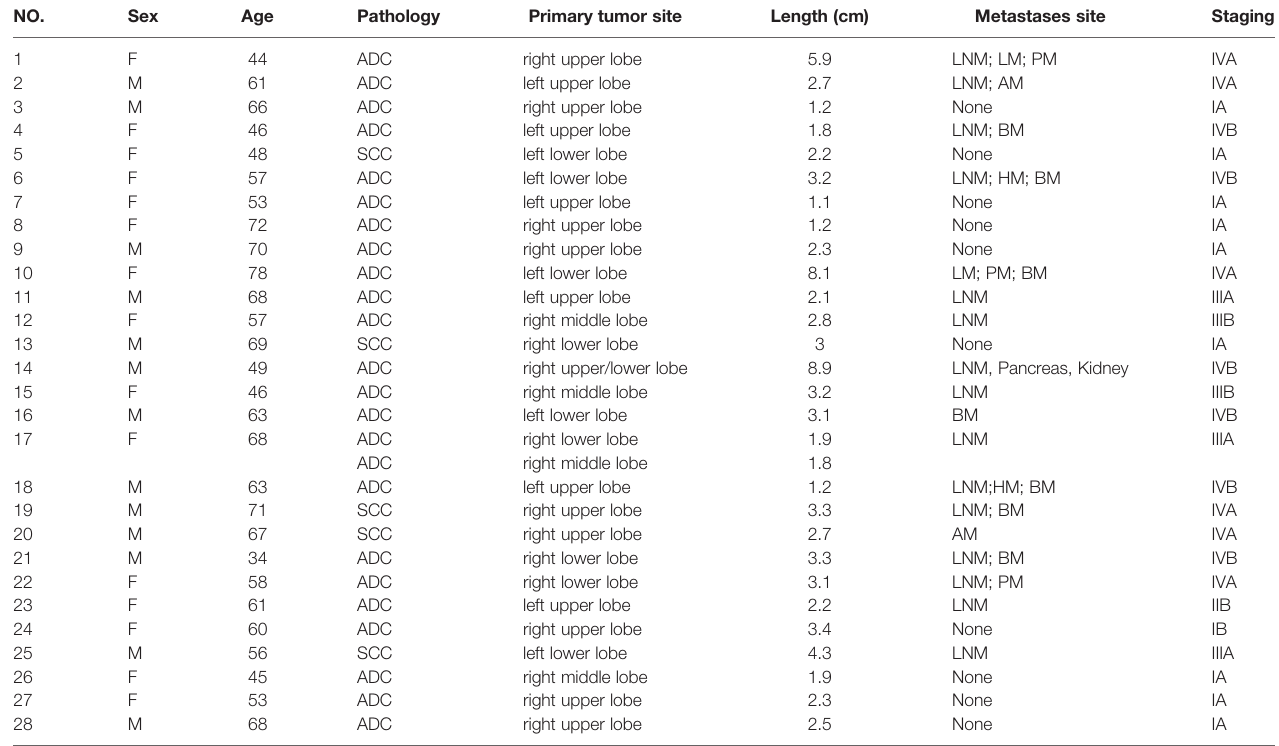
TABLE 1 | Basic patient